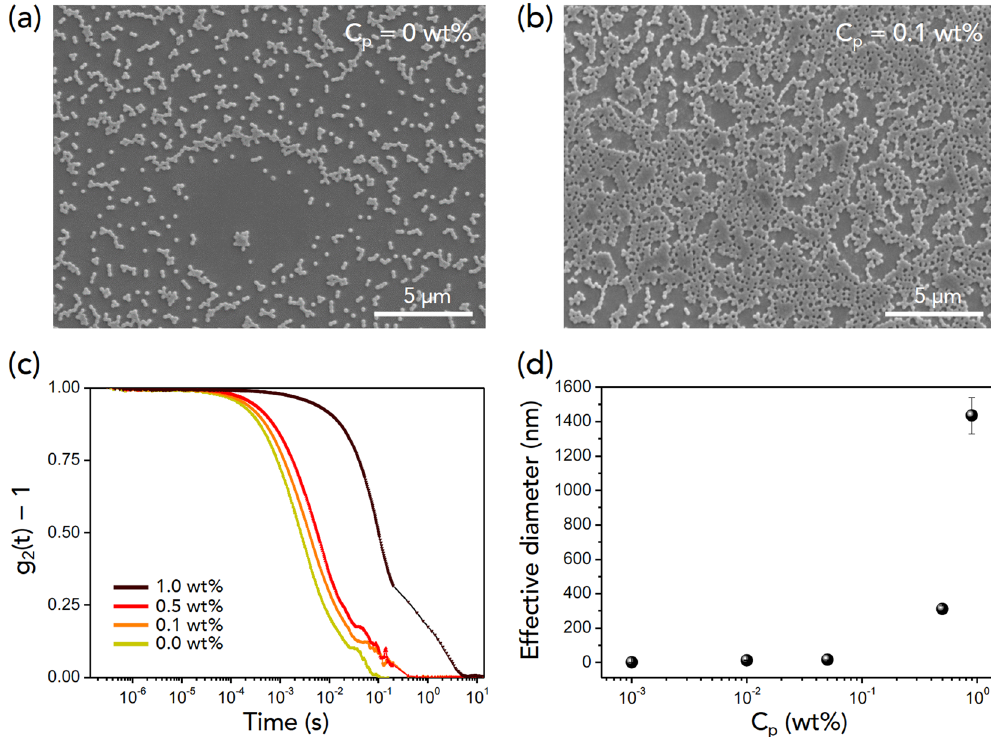
Figure 2. Colloid-polymer interactions for small colloids. ( a , b ) SEM images for the center of the dried droplet with small (100-nm-diameter) colloids without polymers ( C p = 0 wt%) and with polymers ( C p = 0.1 wt%). ( c , d ) Light scattering experiments. The intensity autocorrelation function g 2 ( t ) − 1 versus time, taken from the diffusing wave spectroscopy (DWS), shows attractive interactions between colloids and polymers. The effective diameter, taken from the intensity average diameter of the dynamic light scattering (DLS), increases with the polymer concentration C p